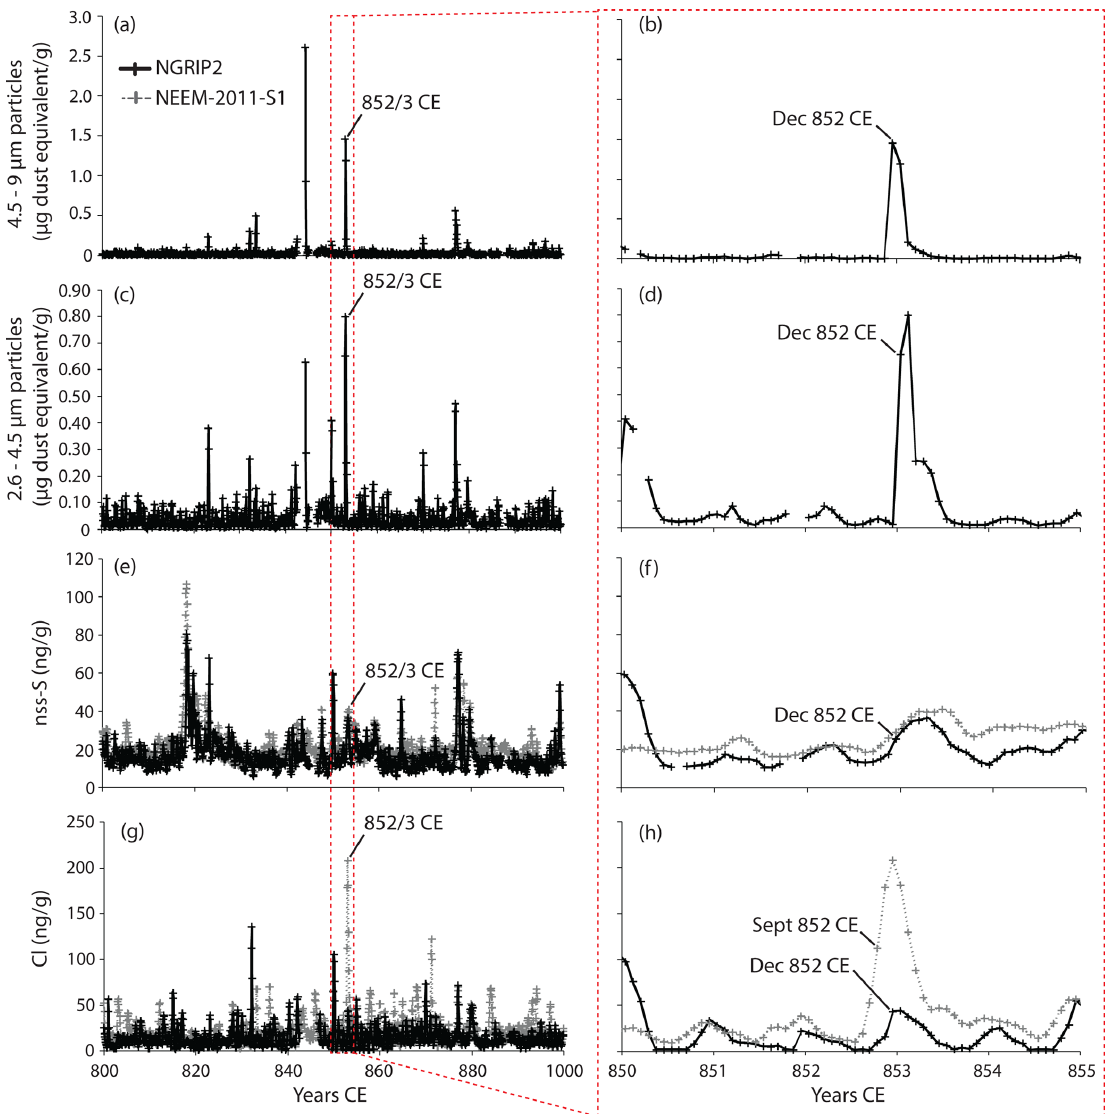
Figure 2. Geochemical characteristics of the 852/3CE Churchill eruption based on concentrations of (a, b) ash inferred from 4.5–9µm particles, (c, d) ash inferred from 2.6–4.5µm particles, (e, f) non-sea salt sulfate (nss-S) and (g, h) chlorine (Cl), from Greenland ice cores NGRIP2 and NEEM-2011 S1 (Jensen et al., 2014) on the NS1-2011 chronology (Sigl et al.,